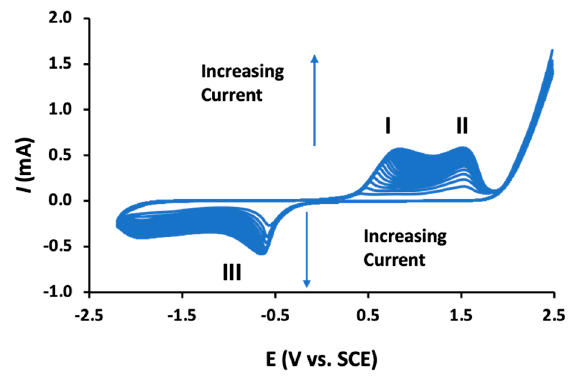
Figure 6. Cyclic voltammograms recorded during the electropolymerization of β -CD in an acidified phosphate buffer, I and II refer to oxidation waves and III to a reduction wave.